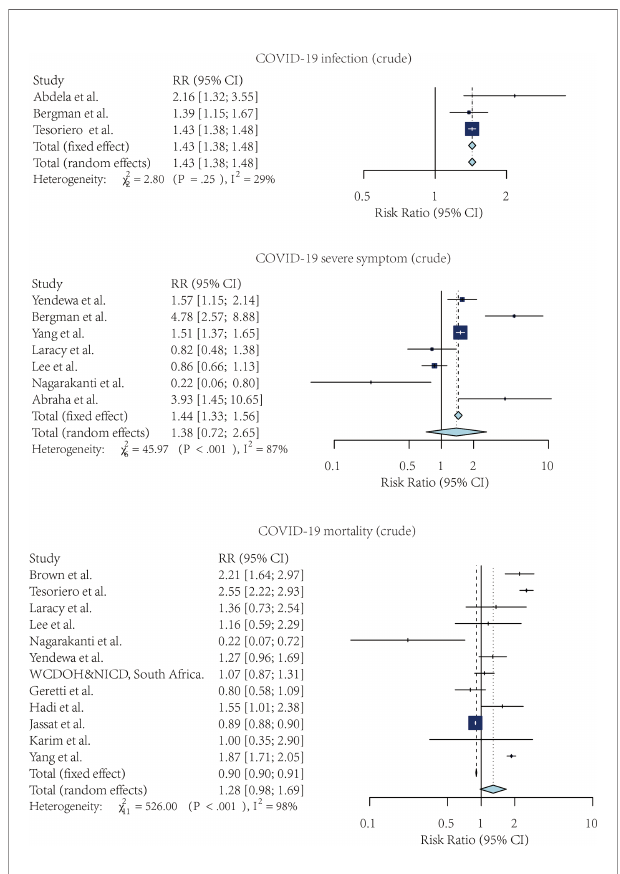
FIGURE 3 | The forest plot of the adjusted risk ratio of SARS-CoV-2 infection, Severe COVID-19 symptoms, and COVID-19 mortality, comparing the patients with and without